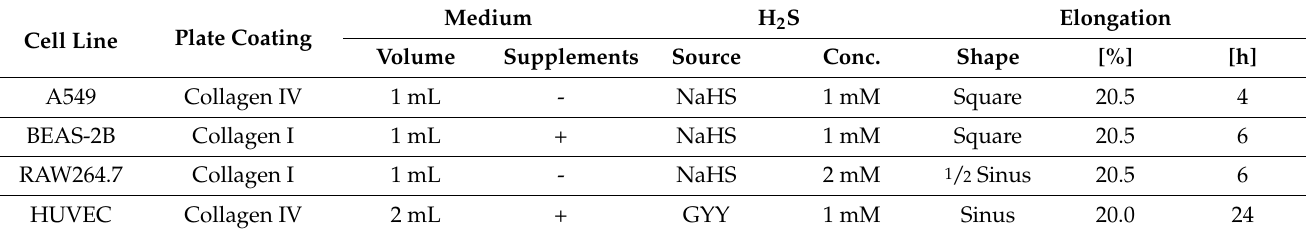
Table 1. Cell stretch experiments–experimental settings. Instrument setup and experimental condi- tions were optimized prior to the experiments for each cell type. V = volume, Supp = supplements, C = concentration, − = without supplements, + = with